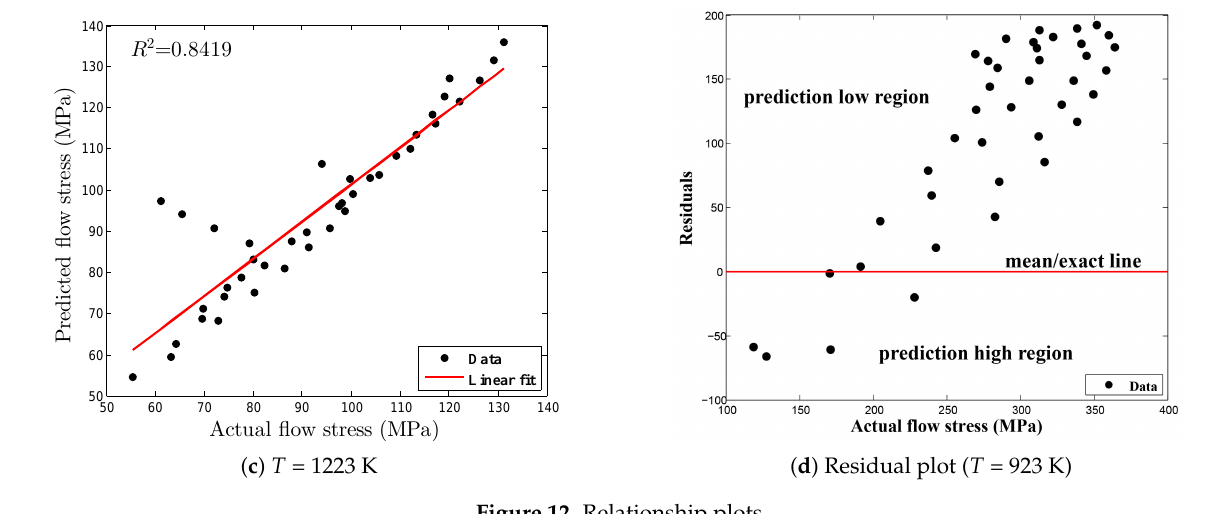
Figure 12. Relationship